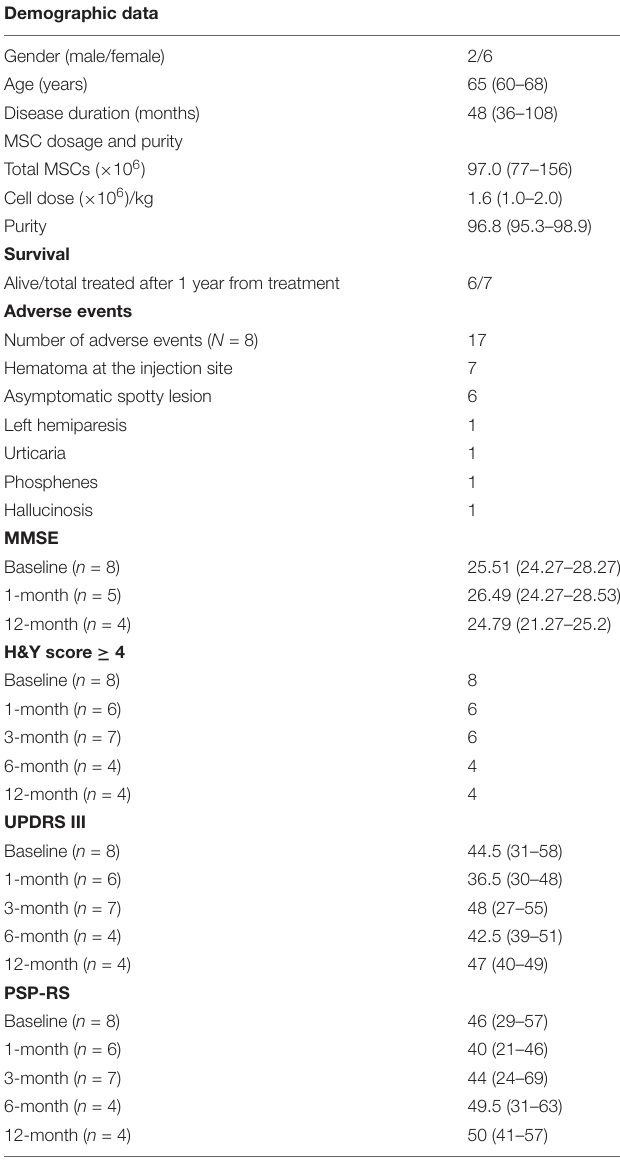
TABLE 1 | Demographic, MSC characteristics, and clinical assessment